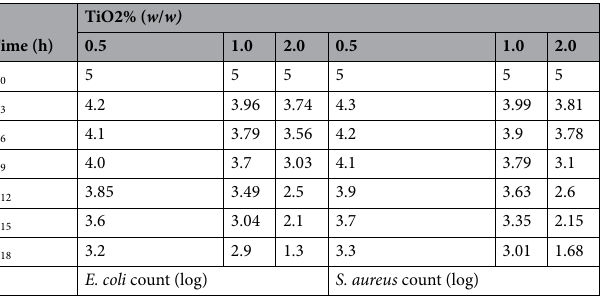
Table 2. Mean bacterial count after exposure to different TiO2 concentrations.